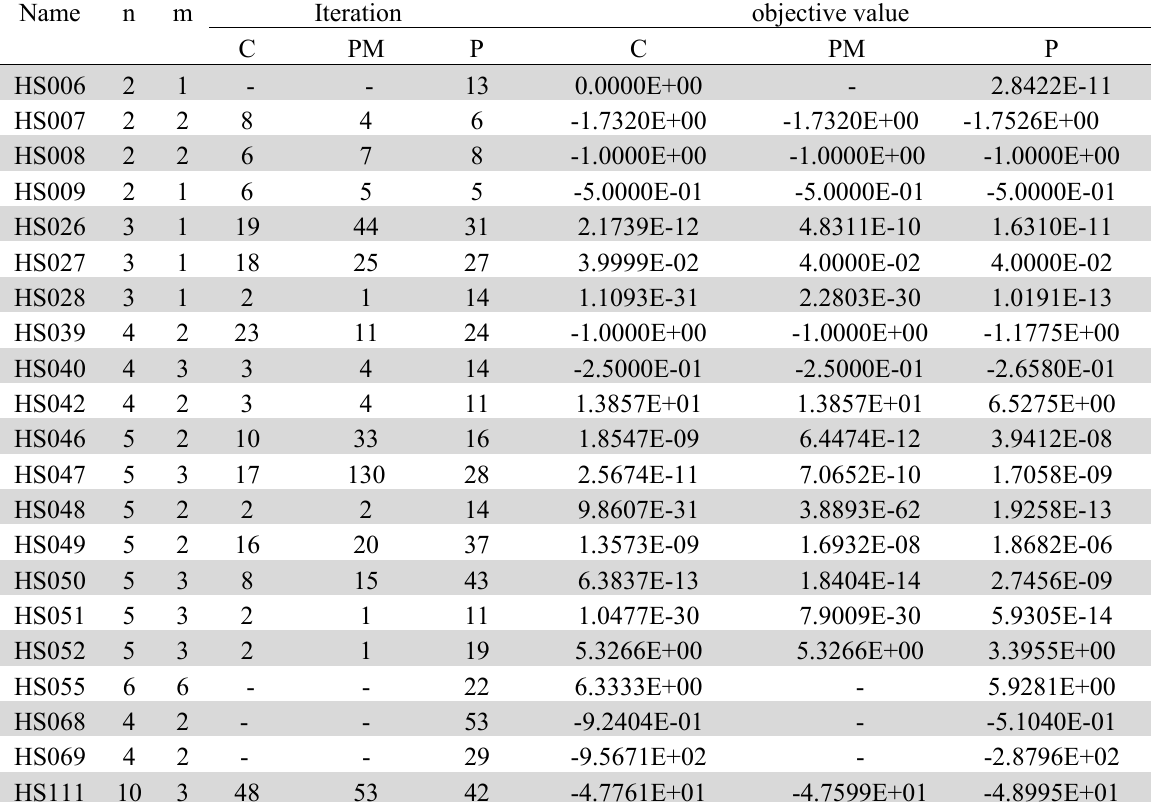
Comparative results of number of iteration and objective value in respect to C, PM and